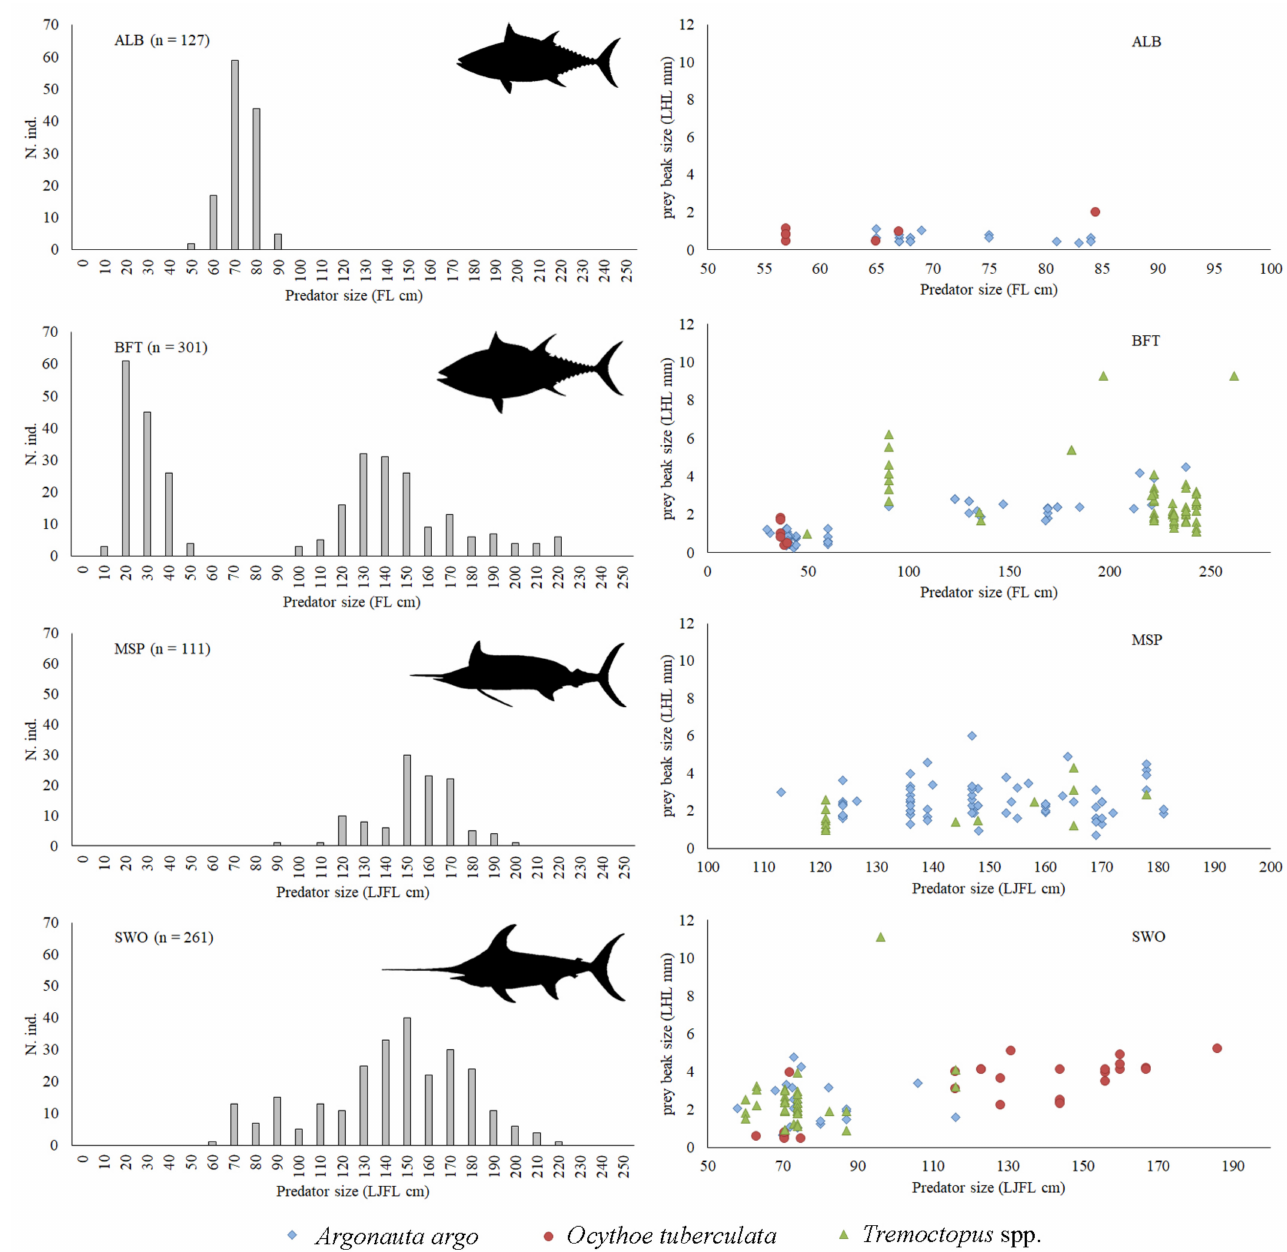
Figure 5. Histograms showing the size frequency distribution for individuals of pelagic predators (ALB = albacore; BFT = bluefin tuna; MSP= Mediterranean spearfish; SWO = swordfish), the stomachs of which were examined. Scatterplots showing the relationship between predator size (fork length FL or lower jaw fork length LJFL) and the lower beak size (LHL) of cephalopod food items belonging to Argonautoidea